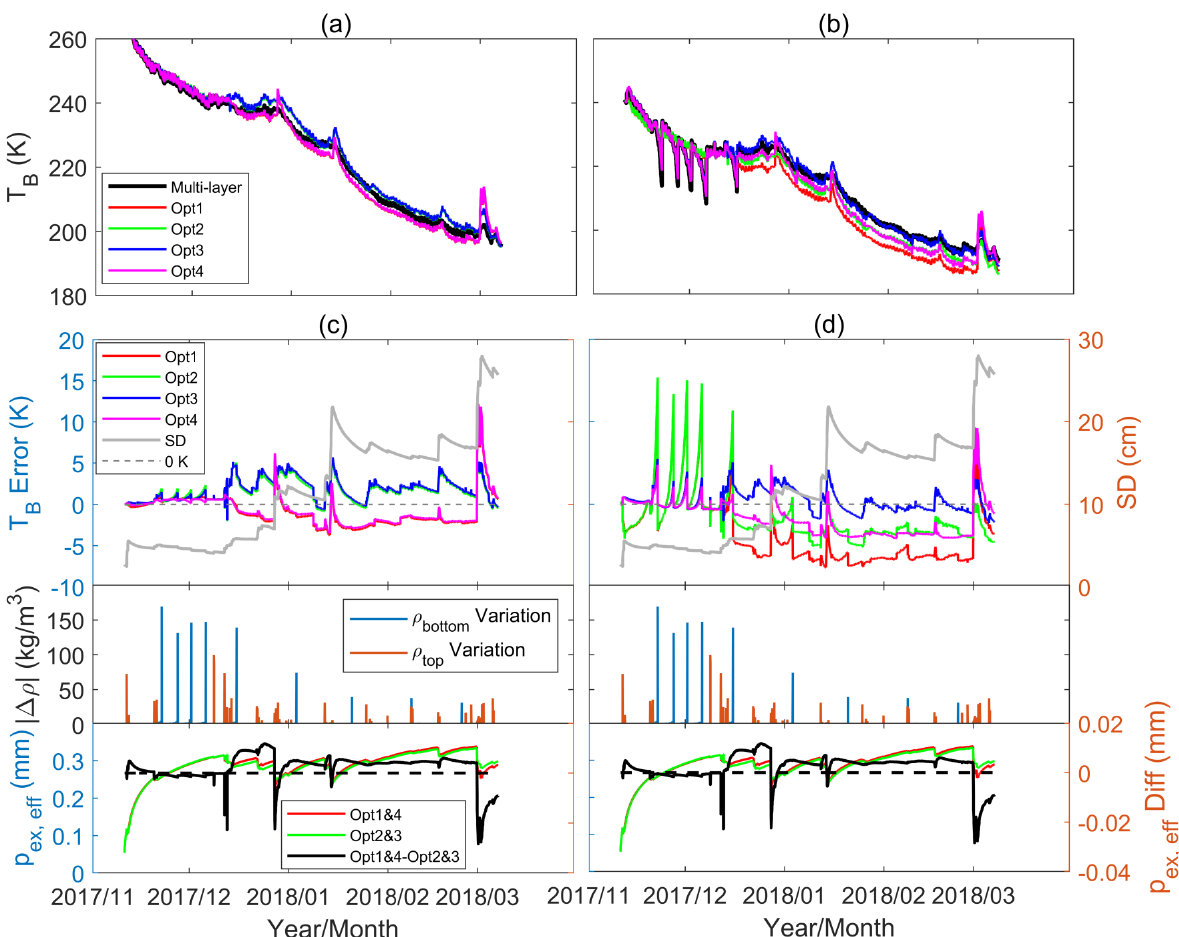
Figure 7. Comparison of MEMLS simulated brightness temperature (T B ) based on a multiple-layer snowpack and single- layer snowpack using four calculation methods at 36.5 GHz: ( a , b ) simulated T B observed at the snow’s surface; ( c , d ) error of bulk T B compared to multiple-layer T B , together with the snow depth (SD), difference ( | ∆ ρ | ) in density of topmost ( ρ top )/bottommost ( ρ bottom ) snow layer between two adjacent samples in time series and the difference ( p ex,eff Diff ) in effective exponential correlation length ( p ex,eff ) used for simulation.